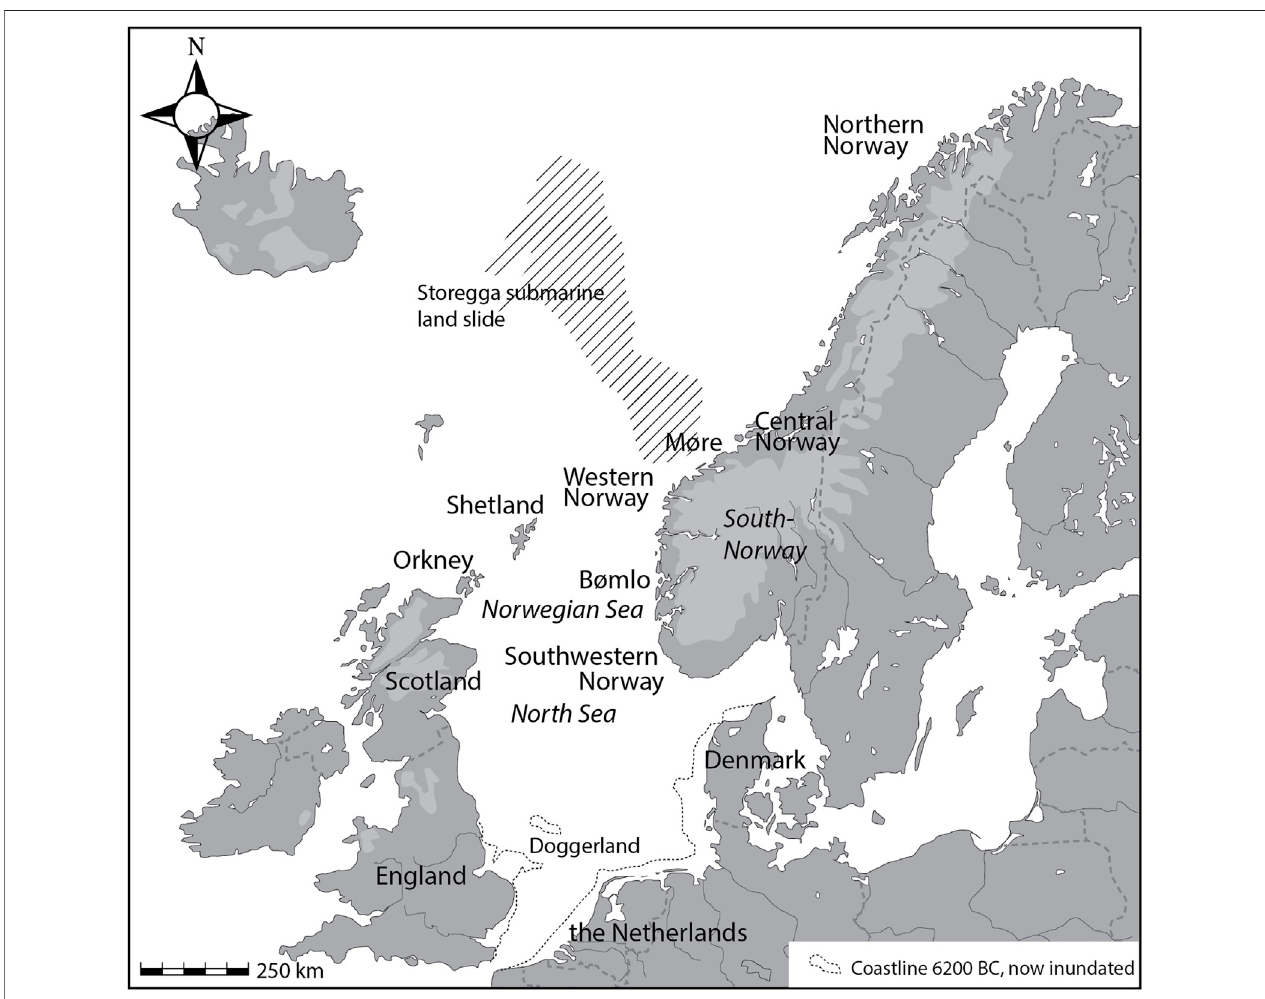
FIGURE 1 | Map with names on regions and places mentioned in the text (Illustration: A.J. Nyland).